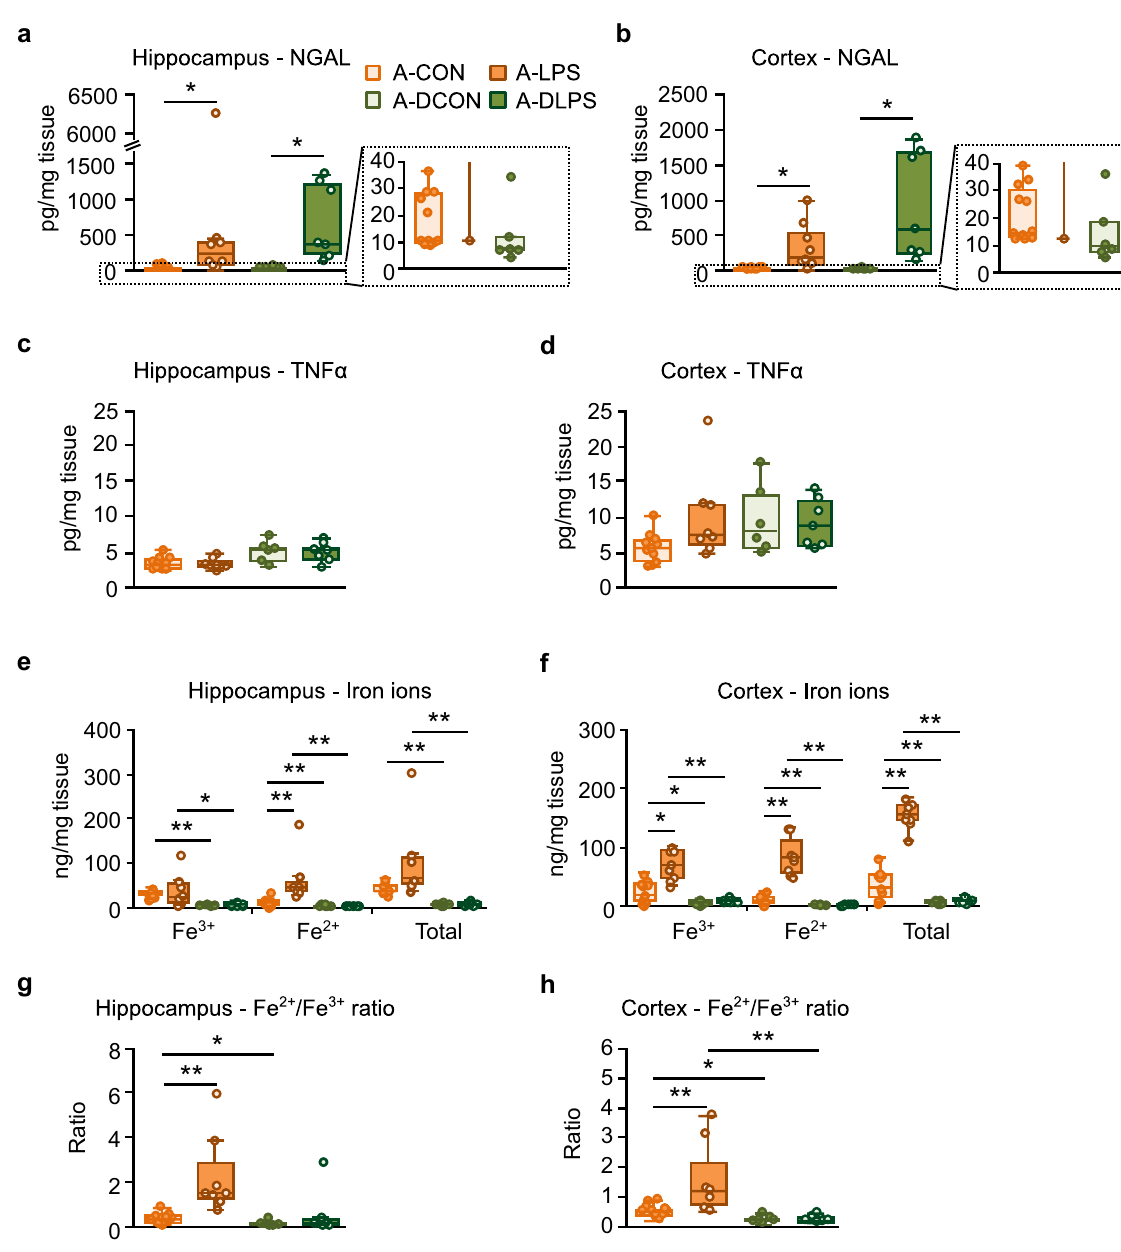
Figure 4. LPS-induced iron ion elevation and imbalance were blocked by pretreatment with DFO in aged sepsis-survivor rats. ( a , b ) A-DLPS rats showed NGAL level elevations in the hippocampus and cortex. ( c , d ) There were no significant differences in the hippocampal and cortical TNFα concentrations among groups. ( e–f ) The hippocampal and cortical iron ion levels in the A-DLPS group were significantly lower than those in the A-LPS group. ( g , h ) The A-DLPS group showed a lower Fe 2+ /Fe 3+ ratio in the cortex but not in the hippocampus than the A-LPS group. DFO treatment significantly reduced each iron ion level and Fe 2+ /Fe 3+ ratio in the hippocampus and cortex. The data are presented as the median ± IQR. A-CON, n = 11; A-LPS, n = 8; A-DCON, n = 6; A-DLPS, n = 7. Permuted Brunner-Munzel test with Bonferroni correction: *P < 0.05, effect size p ̂ ≥ 0.89, **P < 0.01, p ̂ ≥ were no significant correlations between the discrimination index and NGAL level in the hippocampus and cortex (Fig. 5a). The Spearman correlation and partial correlation analysis controlling for NGAL revealed that the Fe 2+ /Fe 3+ ratio in the hippocampus and cortex had a significant negative correlation with the discrimination index (Fig. 5b).